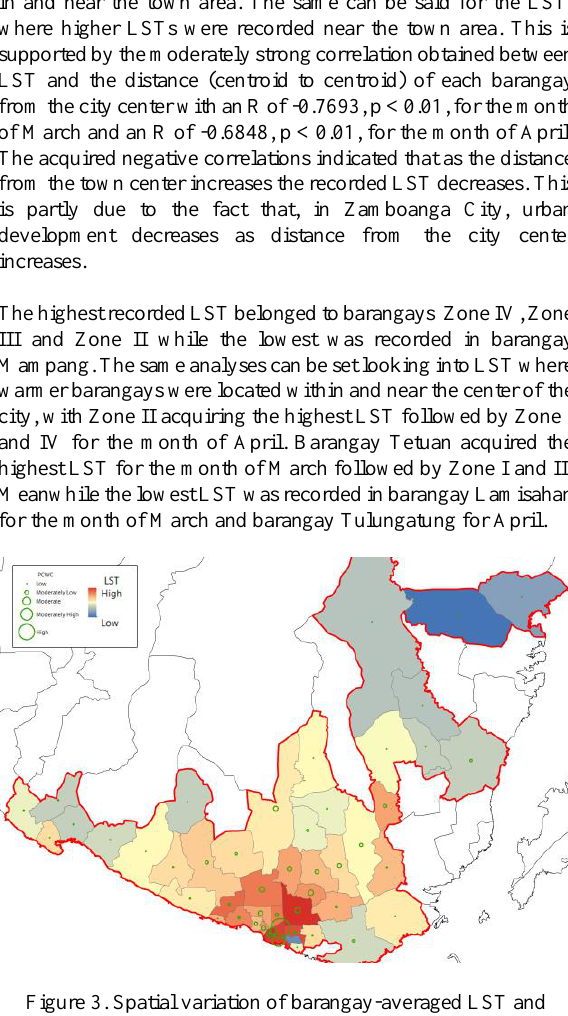
Figure 3. Spatial variation of barangay-averaged LST and PCWC data of the 49 barangays for March